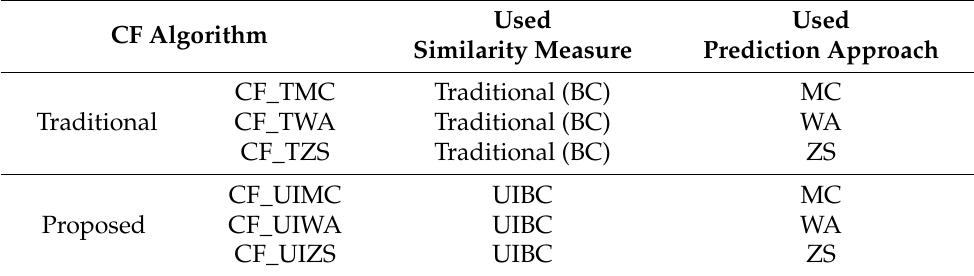
Table 15. Details of used similarity metrics and prediction